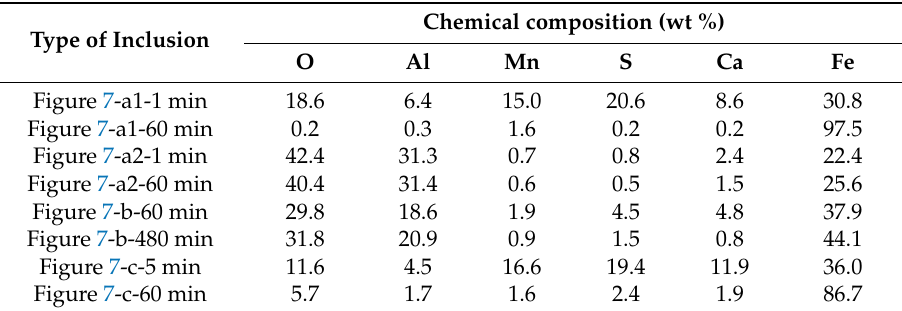
Table 4. Element percentages of inclusions in Figure 7, obtained by EDS.